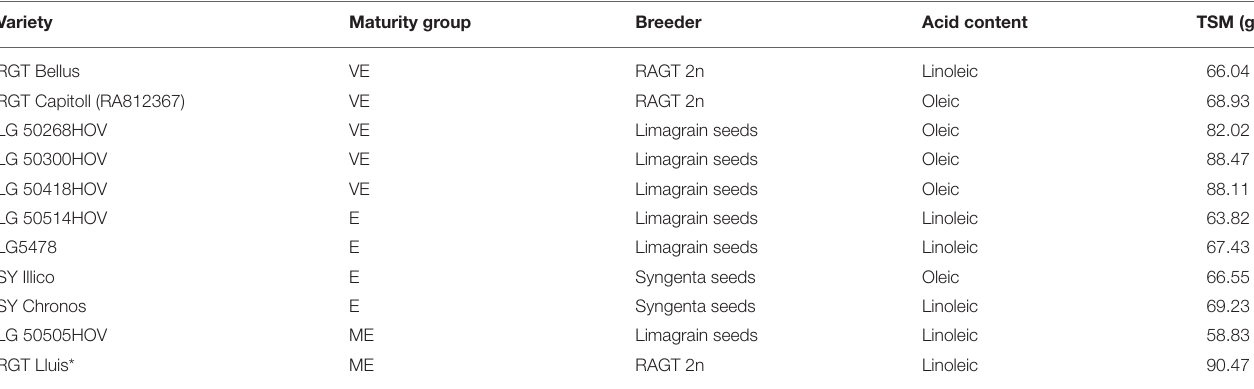
TABLE 1 | Key characteristics of 11 hybrid oilseed varieties of sunflower tested under laboratory conditions in 2020. Variety Maturity